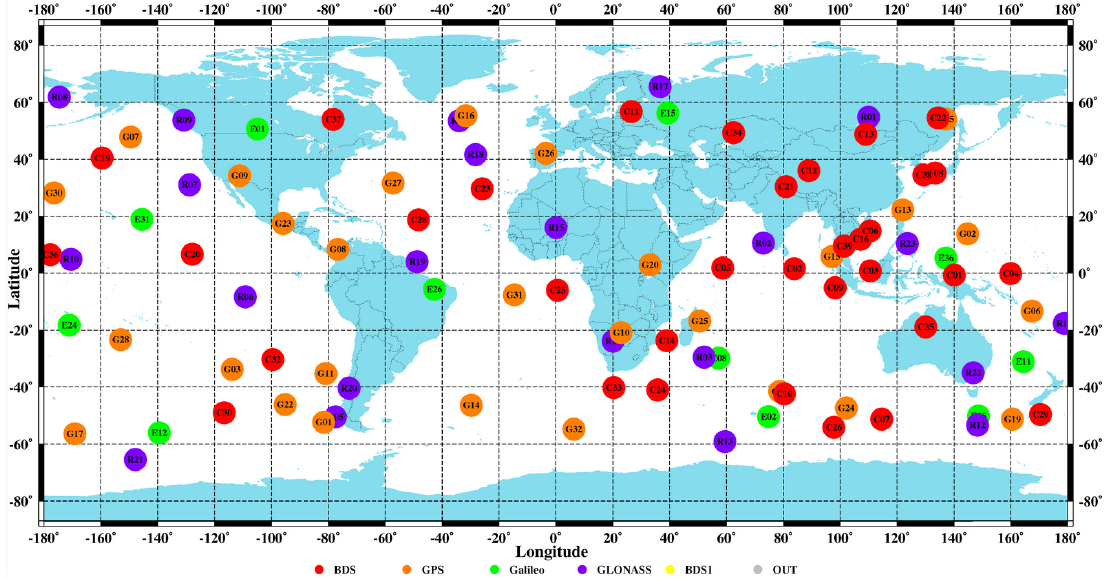
Figure 1. GNSS satellites’ positions at 23:00 on 31 December 2019 (from http://www.igmas.org, retrieved on 7 February